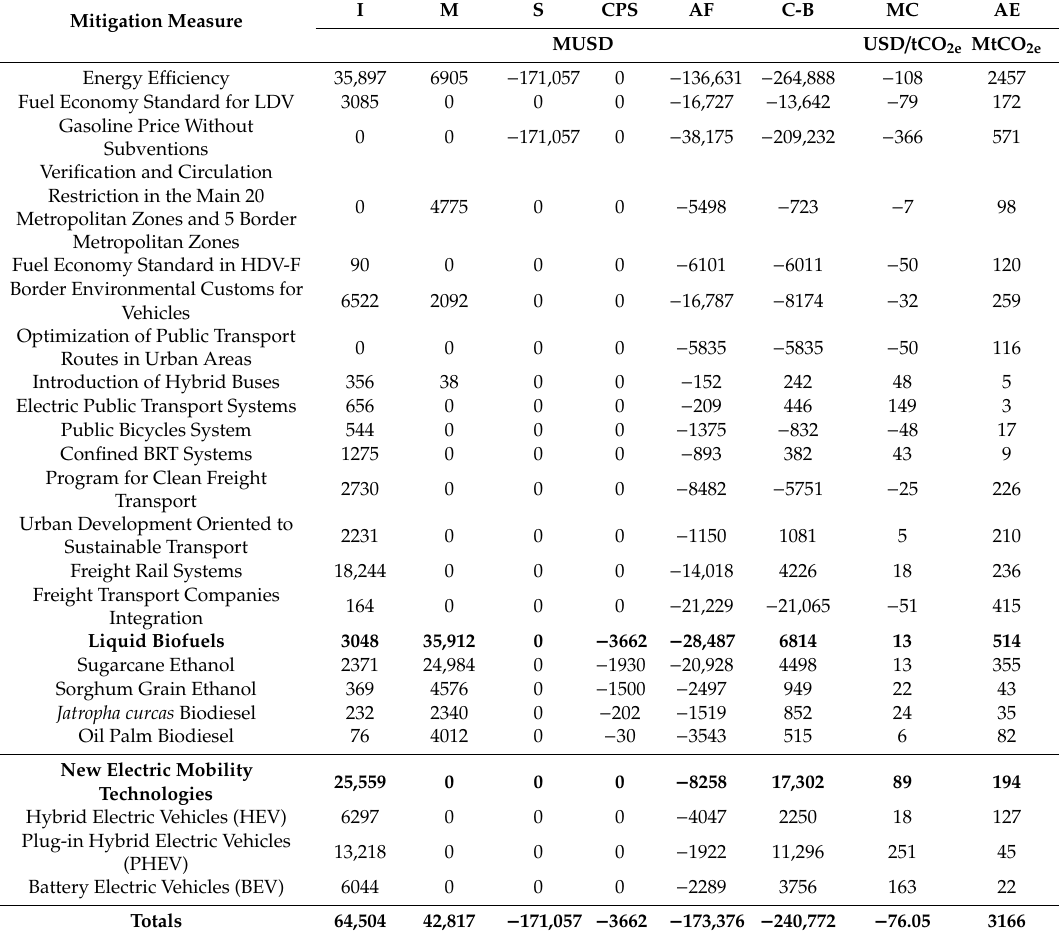
Table 12. Avoided GHG costs and emissions from mitigation measures in the transport sector in Mexico during 2010–2035